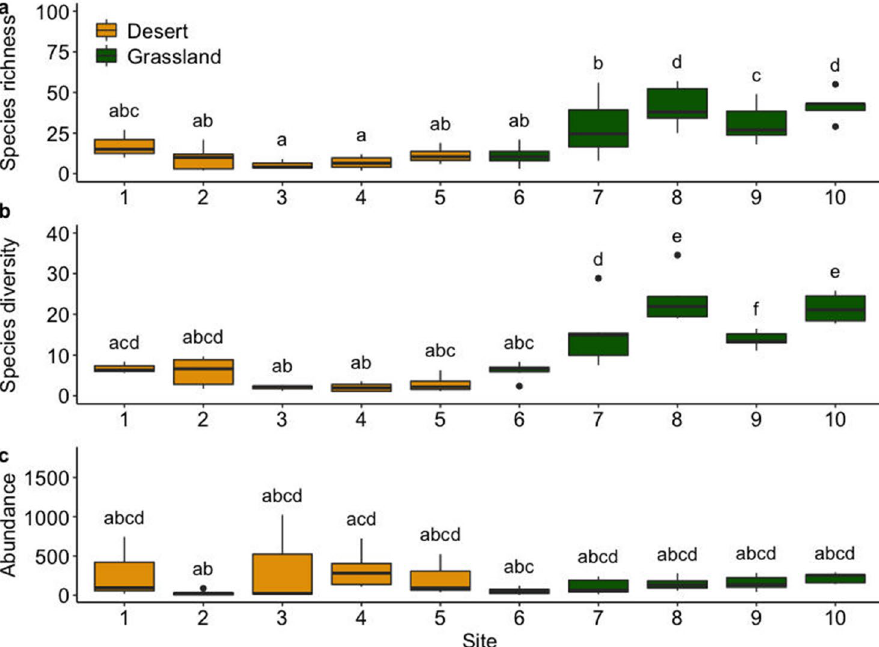
Figure 2. Species richness, Shannon diversity and abundance of ten sites along the latitudinal gradient. Diversity metrics were compared with Wilcoxon test based on the sampling nights of each site. Different letters show significant differences between sites. See the further comparison of species richness, species diversity and abundance at the family level in Fig. S2, Tables S4, S5 and S6 of supplementary material.